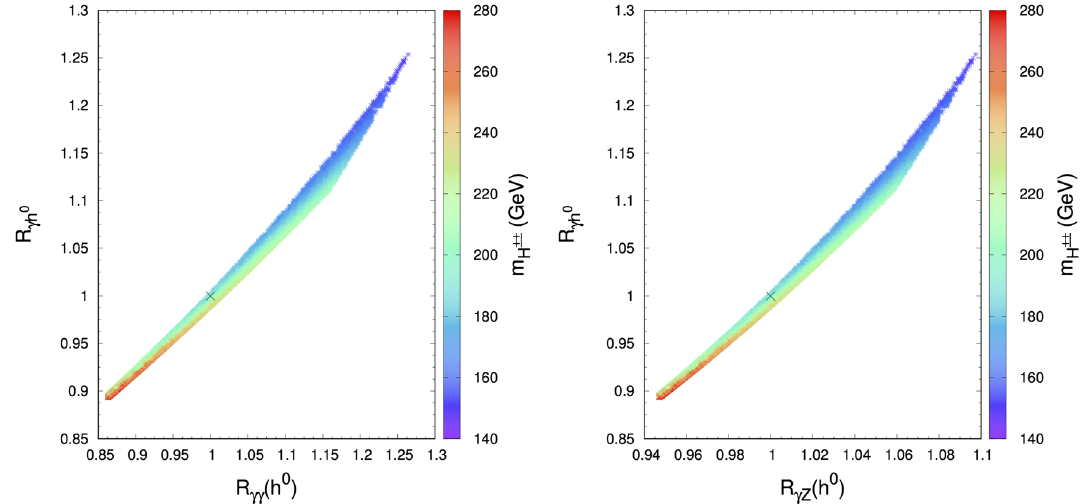
Fig. 6 R γ h 0 correlation with R γγ ( h 0 ) (left) and R γ Z ( h 0 ) (right) in the HTM. Color coding shows the variation of m H ±± . Inputs as in Fig. 5